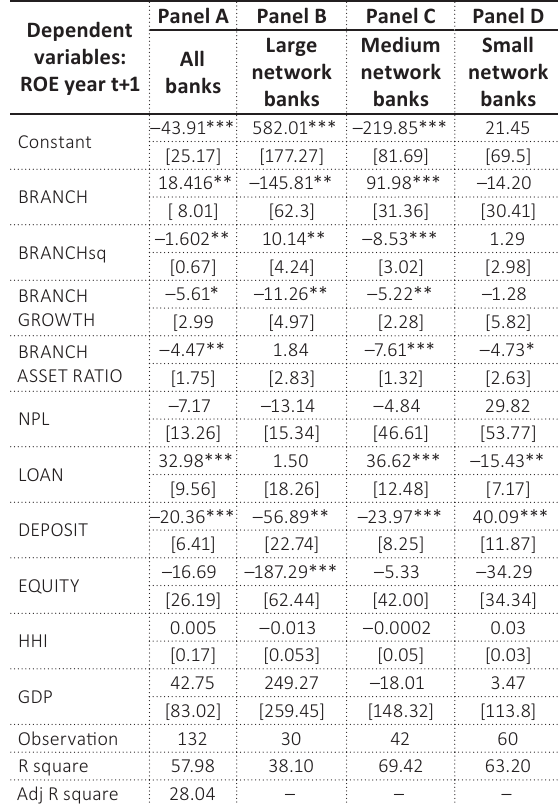
Table 5. Multiple regression